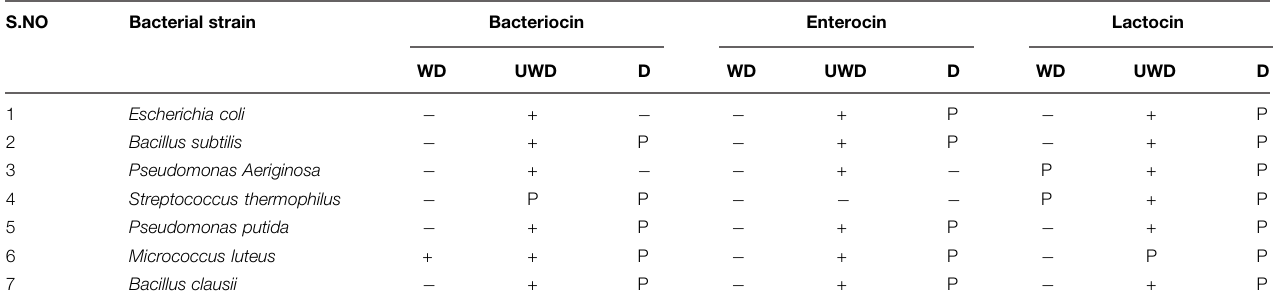
TABLE 3 | Comparative study of bacteriocin, lactocin, and enterocin on different formats such, as well diffusion (WD), unique well diffusion (UWD), and disk diffusion (D). S.NO Bacterial strain